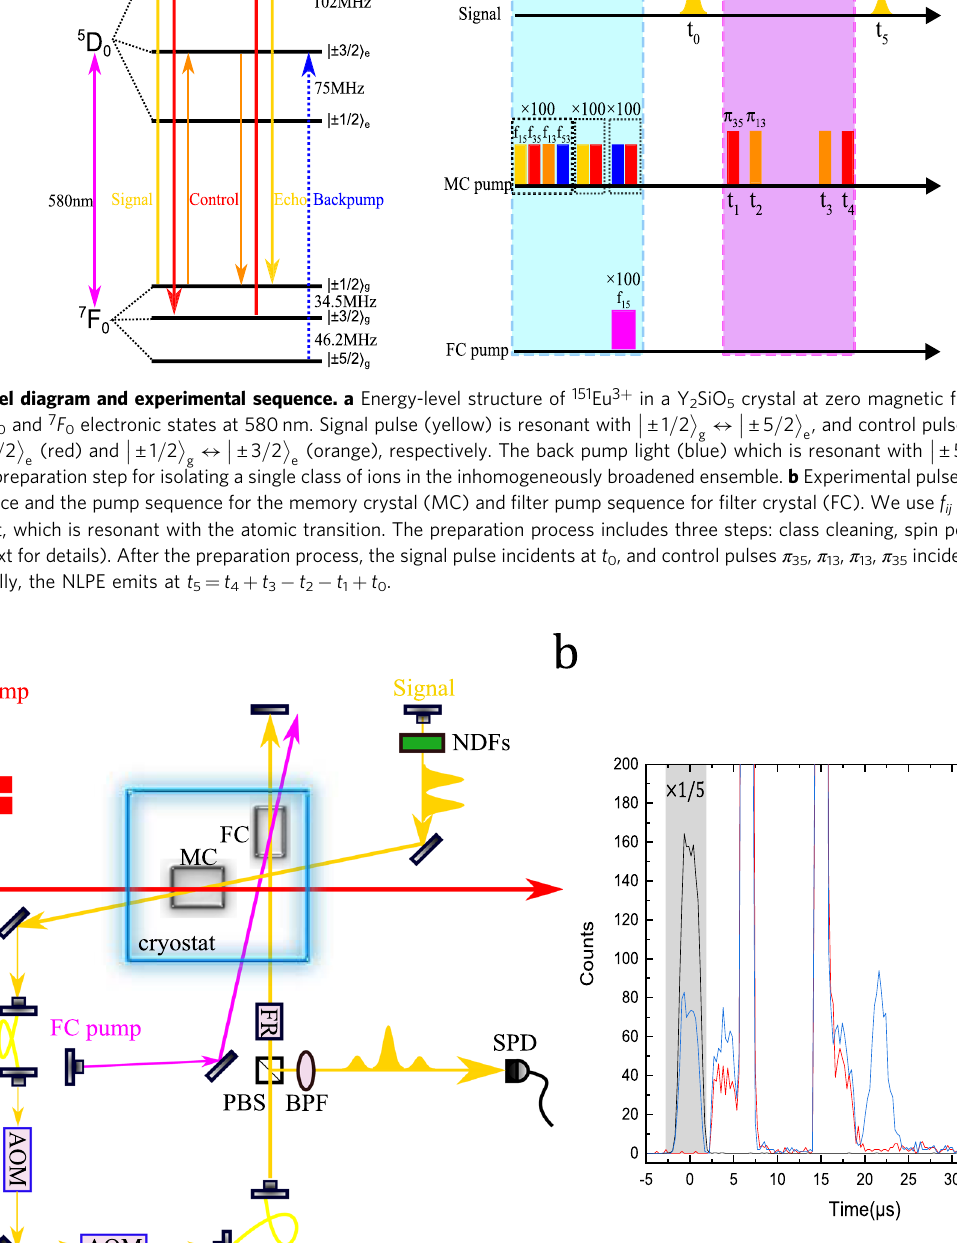
Fig. 2 Experimental setup and photon counting histogram. a Schematic of the experimental setup. The signal beam and the pump beam for the memory crystal (MC) counter propagate with each other and overlap on the MC with a small angle. The signal beam is attenuated to the single-photon level by neutral density fi lters (NFDs). The readout signal is collected by a single-mode fi ber and passes through two acoustic-optic modulators (AOM) to shift the optical frequency by 400MHz. The signal is spectrally fi ltered by the fi lter crystal (FC) and two 1-nm band-pass fi lters (BPF). The FC is doubled passed with the help of a polarization beam splitter (PBS) and a Faraday rotator (FR) and the signal is fi nally detected by a single photon detector (SPD). b Photon counting histogram for storage of weak coherent pulses with an average photon number of 1.17 ± 0.11 photons per pulse. The blue and red lines correspond to measurements with input and without input, respectively. The input (black line) is also included for reference. The input and signal data inside the shadowed area is mini fi ed by fi ve times. The bin size is 262 ns, and the experiment is repeated for 50,000 below 1 kHz. The laser is split into three beams, the input mode, in the memory crystal and the fi lter crystal, there is a center the pump mode for memory crystal, and the pump mode for the frequency difference of ~1 GHz for the optical absorption. To fi lter crystal. The non-collinear con fi guration of the signal beam enhance the effective absorption of the fi lter crystal, two acoustic- and the counter-propagating control beam suppress noise in the optic modulators (AOM) are employed to shift the signal spatial domain. Due to the different concentrations of Eu 3 + ions frequency by 400 MHz before entering the fi lter crystal.